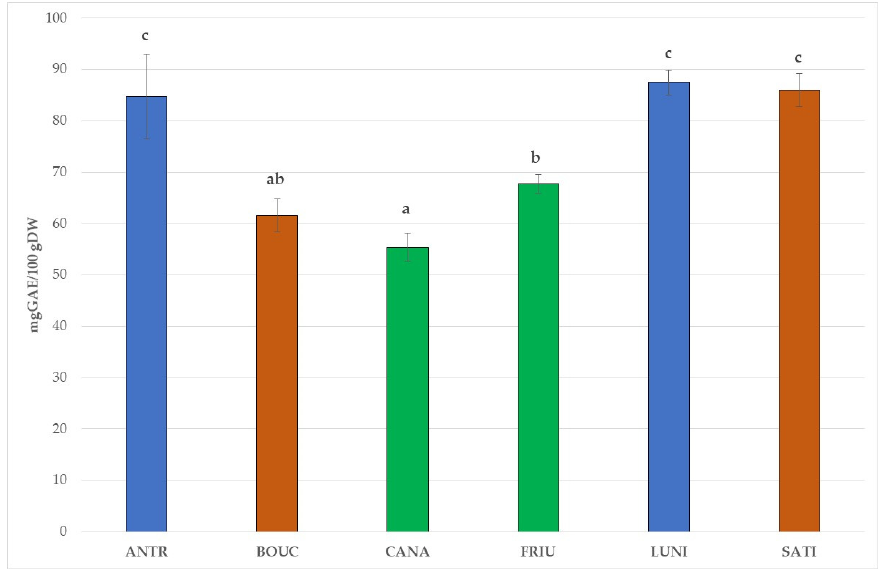
Figure 1. Total polyphenolic content of the analysed chestnut flours. Different letters for each flour indicate the significant differences at p < 0.05. Blue colour: commercial flours from Lazio (ANTR) and Toscana (LUNI); orange colour: flours from Piemonte; green colour: flours from Friuli-Venezia Giulia.